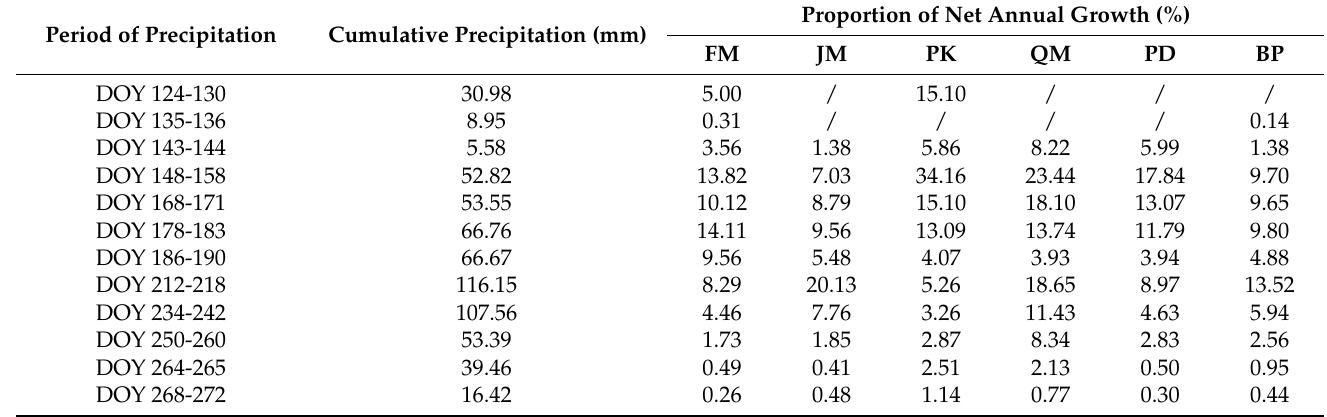
Table 2. Proportion of the corresponding increment of six tree species in each precipitation period to the annual net growth. “/” indicates that the growth period is not within the annual net growth period or the diameter change in this period is negative.